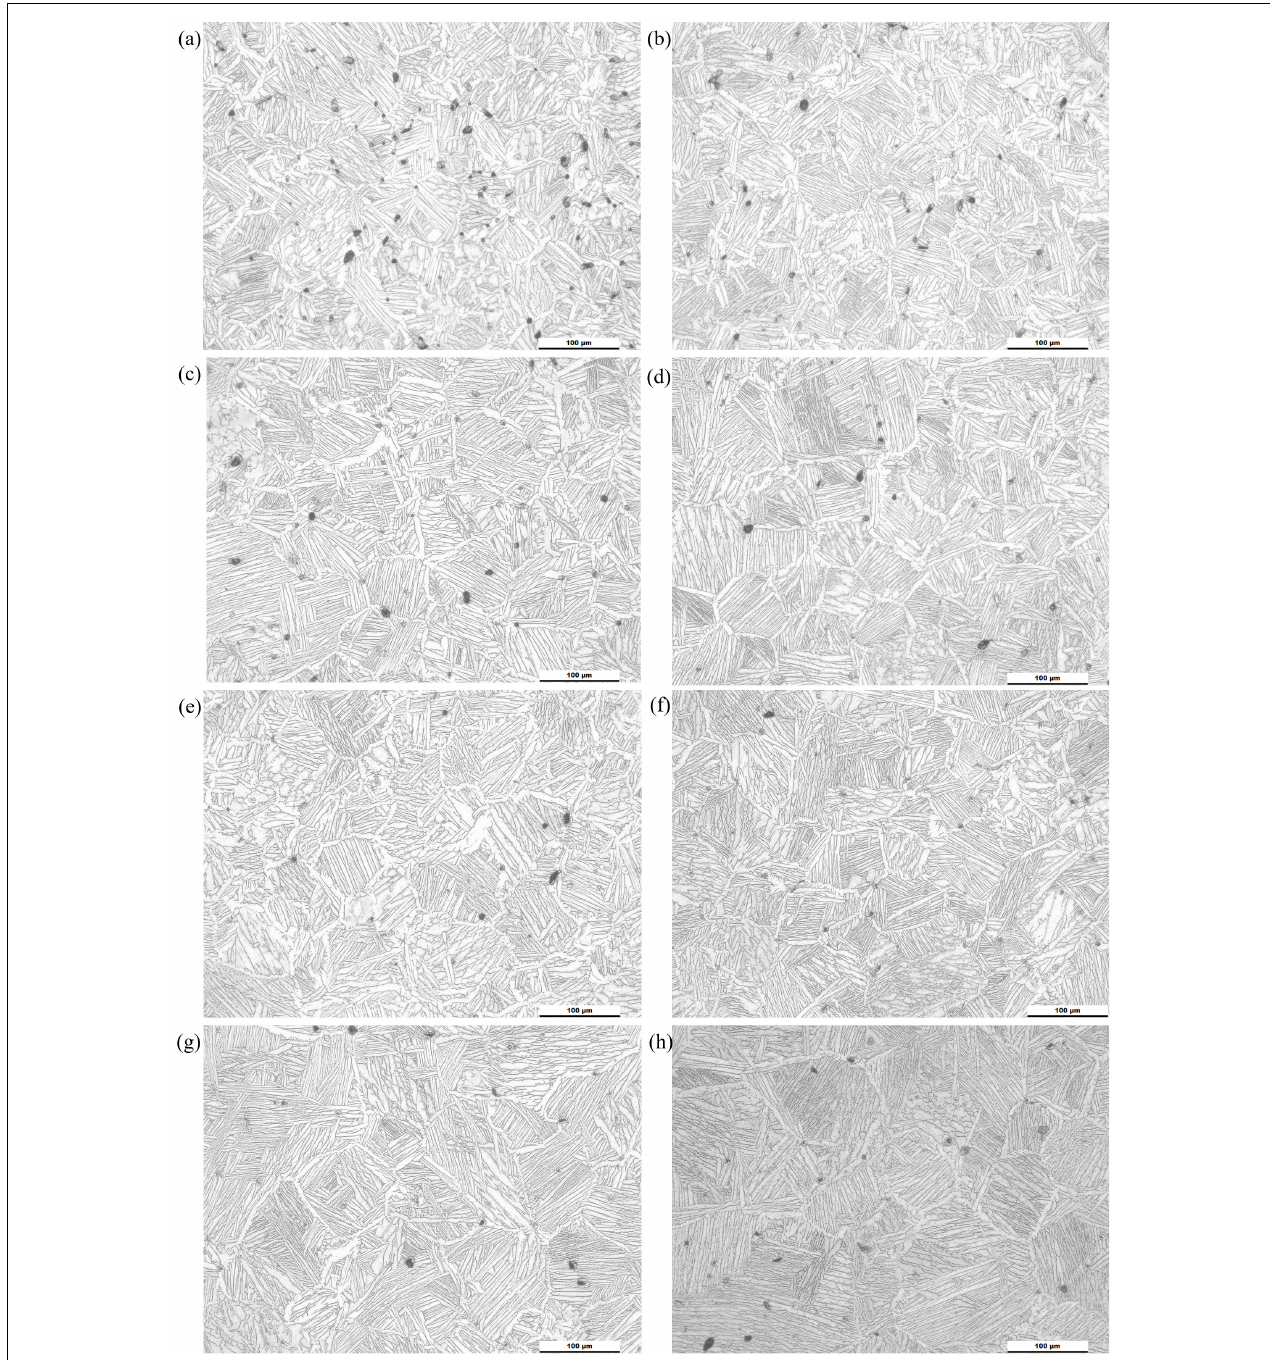
FIGURE 3 | Microstructure of sintered material: (a,c,e,g) represent 3 h at 1100, 1150, 1200, 1250 ◦ C; (b,d,f,h) represent 4 h at 1100, 1150, 1200, 1250 ◦ C, respectively.